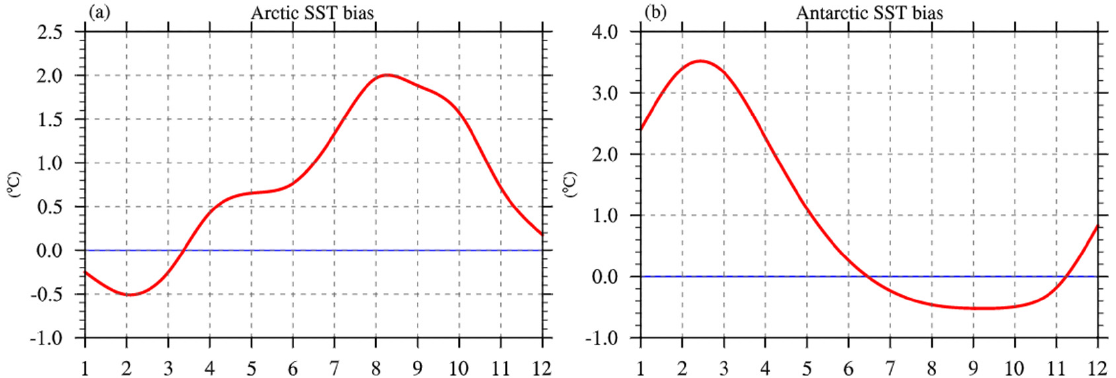
Figure 5. Comparison between CAS-ESM 2.0 and NCEP [35] observations for seasonal SAT cycle in 1979–2014 in ( a ) Northern Hemisphere (north of 45° N) and ( b ) Southern Hemisphere (south of 45° S).